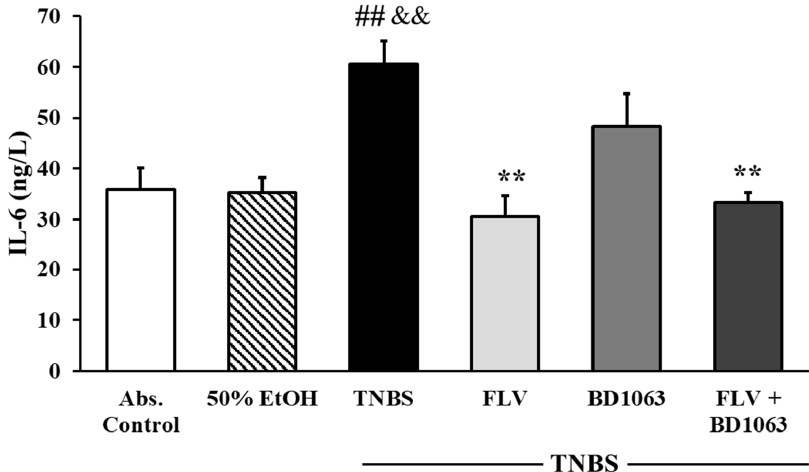
Figure 6. E ff ects of sigma-1 receptor ( σ 1R) agonist and antagonist on the levels of interleukin-6 (IL-6). Abs. control (no treatment), 50% EtOH (50% ethanol enema), TNBS (2,4,6-trinitrobenzenesulfonic acid enema), FLV (TNBS enema + 1 mg / kg Fluvoxamine (FLV)), BD1063 (TNBS enema + 0.1 mg / kg BD1063), FLV + BD1063 (TNBS enema + 1 mg / kg FLV + 0.1 mg / kg BD1063). Data are represented as mean ± SEM; ( n = 6–8); statistical significance ## p < 0.01 Abs. control vs. TNBS; ** p < 0.01 TNBS vs. TNBS + Treatment; && p < 0.01 EtOH vs. TNBS. Int. J. Mol. Sci. 2020 , 21 , x FOR PEER REVIEW